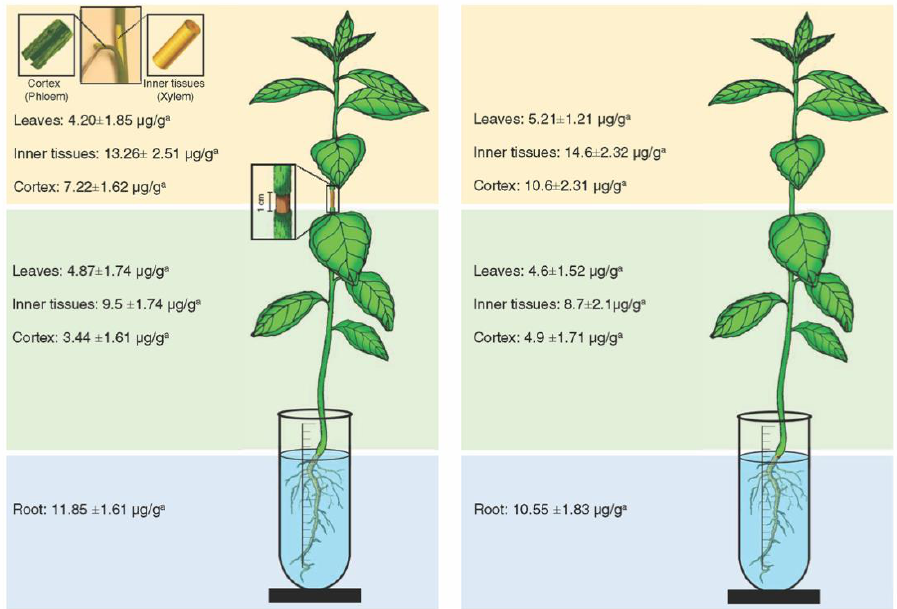
Figure 2. Level of oxytetracycline in different citrus plant tissues after root drench of girdled ( left ) and non-girdled ( right ) seedlings in oxytetracycline solution (200 µg mL −1 ) for 24 h. For these analyses, the stem cortex was dissected into the outer cortex tissue (representing the phloem) and the inner cortex (representing the xylem). Data are the means ± SD of five biological replicates. Means in the same line with different superscript letters are significantly different ( p- value < 0.05).